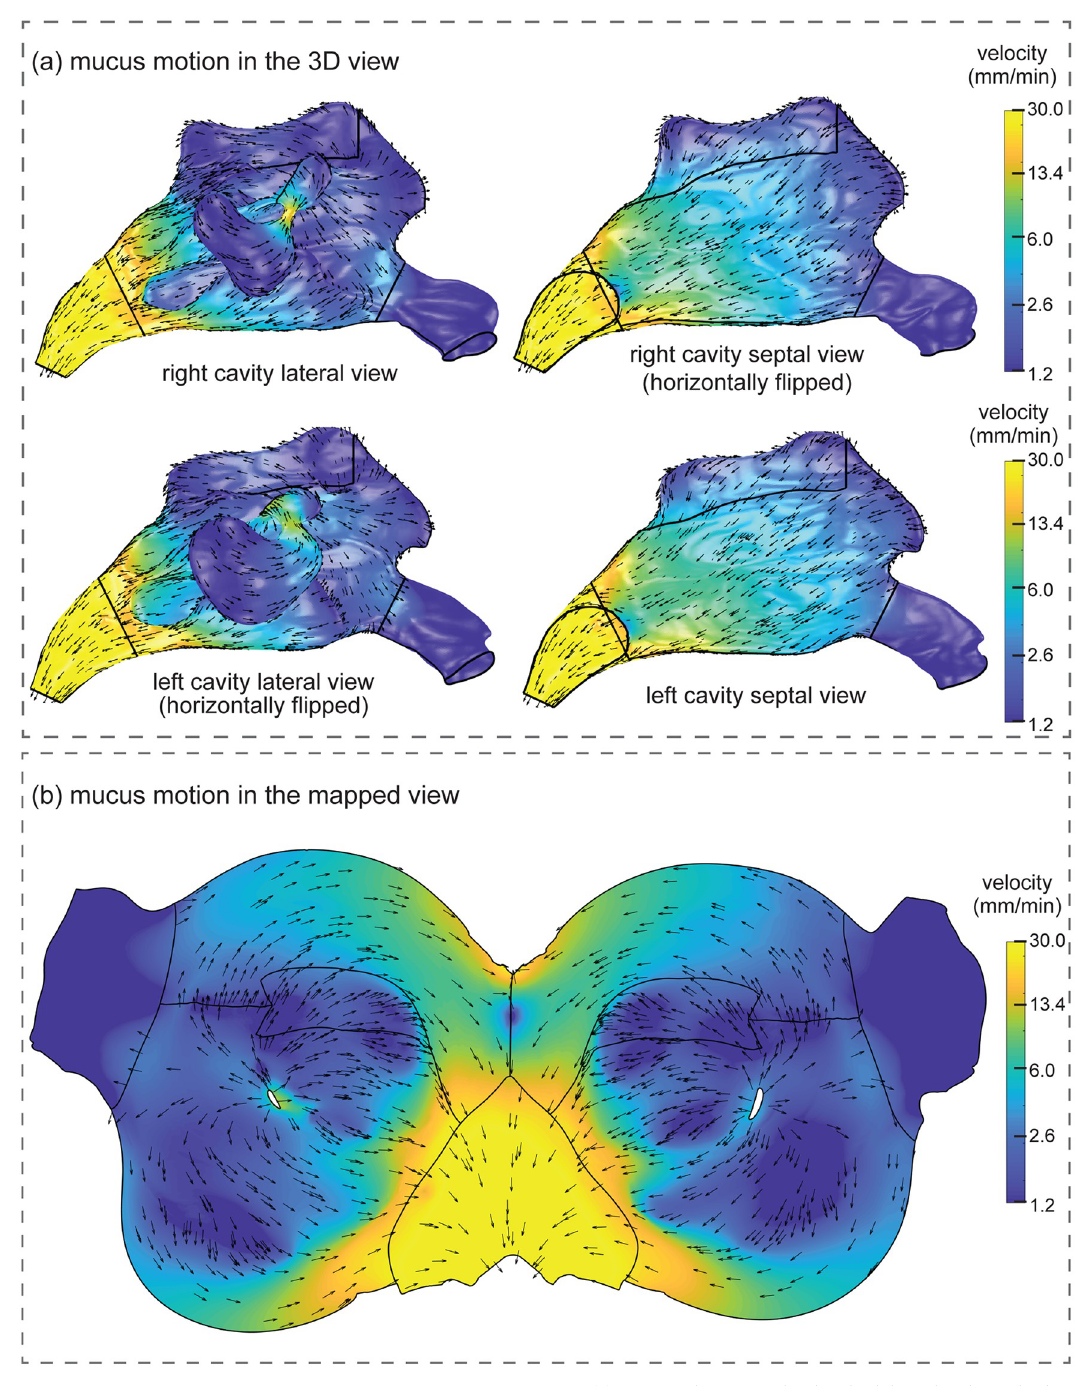
Fig 7. Simulated mucus velocity distribution on the nasal cavity wall. (a) Mucus velocity visualised on both lateral and septal sides of the left and right nasal cavities separately. (b) Mucus velocity visualised in a surface-unwrapped domain.